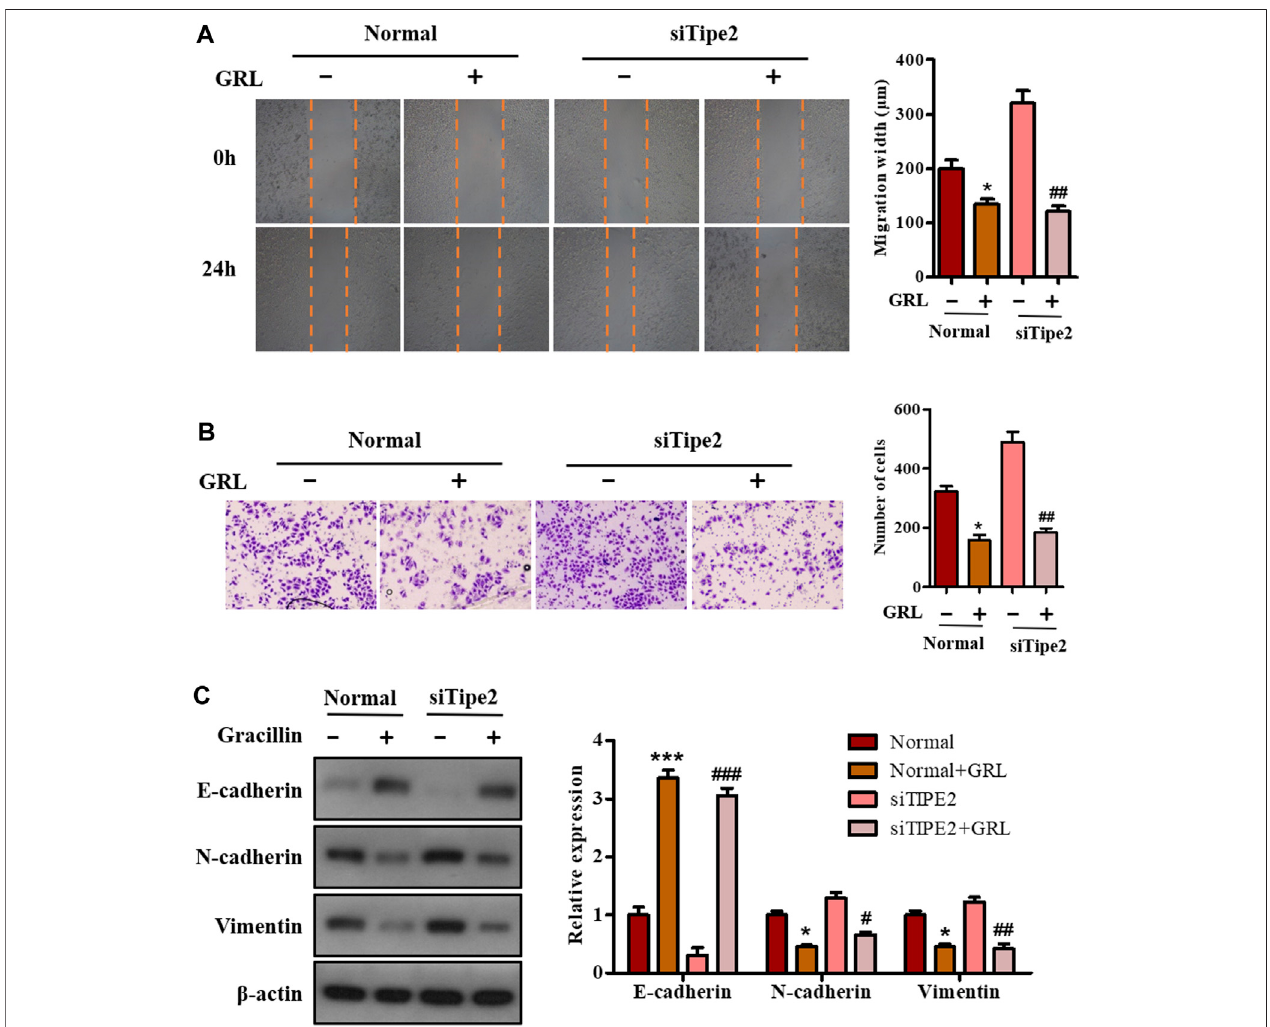
FIGURE 6 | The role of TIPE2 in the cell migration mediated by gracillin in BGC823 cells. (A) Scratch assay for cell migration by TIPE2 and gracillin. BGC823 cells and TIPE2 siRNABGC823 cellsweretreated with3 μ Mgracillin for24 h. (B) Transwellassayforcellmigration byTIPE2 andgracillin. (C) Western blotfortheexpression of E-cadherin, N-cadherin, and vimentin. 0.01 < p < 0.05 (*) represents a signi fi cant difference and p < 0.001 (***) represents an extremely signi fi cant difference to the normalcontrol;0.01 < p < 0.05( # )representsasigni fi cantdifference, 0.001 < p < 0.01 ( ## )representsaverysigni fi cantdifference and p < 0.001( ### )representsan extremely signi fi cant difference to the TIPE2 siRNA